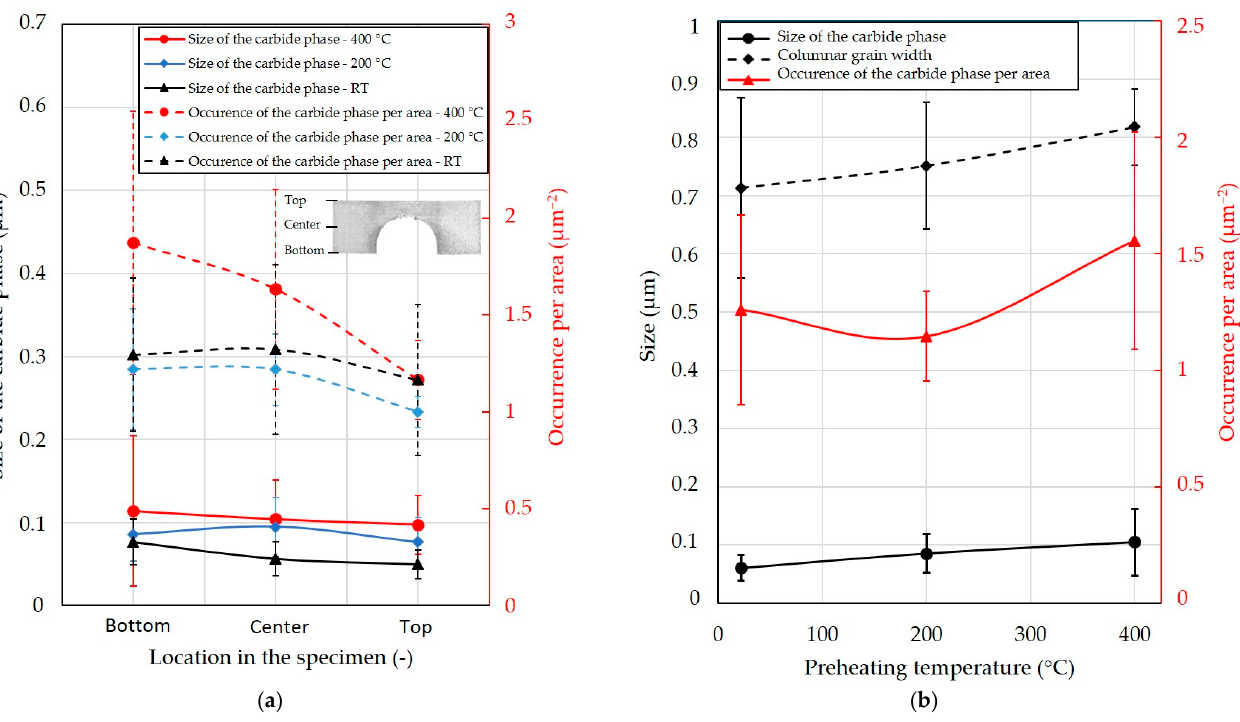
Figure 7. The effect of location in the specimen and preheating temperature on microstructure properties of IN939 fabricated at different preheating temperatures. ( a ) Effect of location in the specimen on the size and occurrence per area of carbide phase. ( b ) Effect of preheating temperature on the columnar grain width, size, and occurrence per area of the carbide phase.